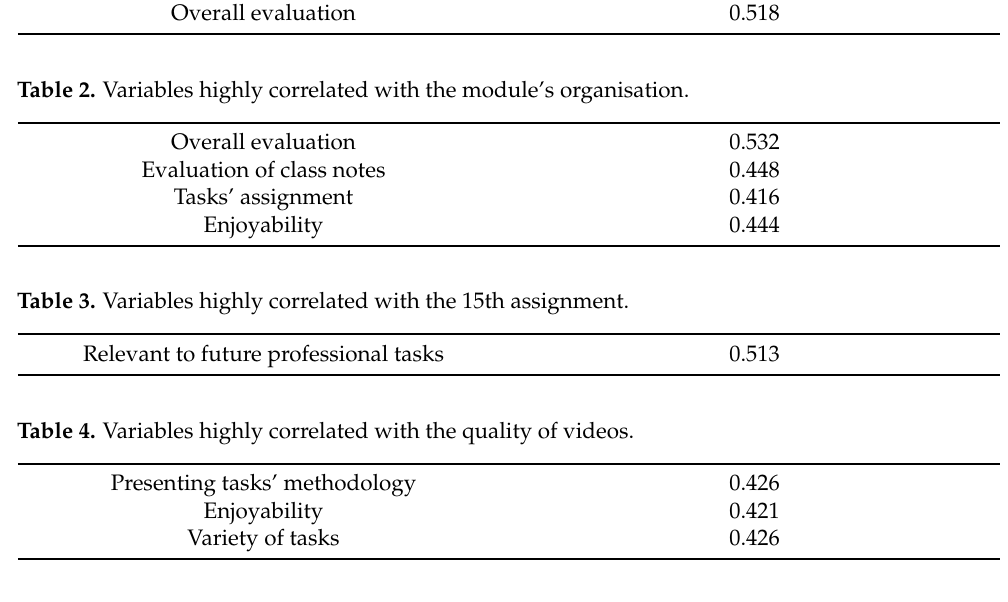
Table 5. Variables highly correlated with understanding 3-dimensional